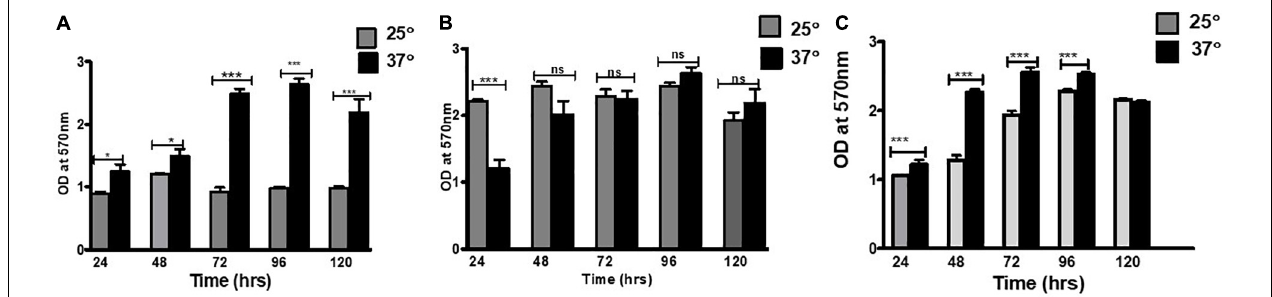
FIGURE 1 | Biofilm formation on various surfaces: (A) glass, (B) enteral feeding tube, and (C) foley latex catheter. To estimate the biofilm production, the crystal violet staining method was used. The graph represents OD 570 depicting a comparison between 25 and 37 ◦ C. An unpaired t -test was used to determine significant differences between the two cultivation temperatures. Statistical significance: * ≤ 0.05, *** ≤ 0.001, ns = not significant.